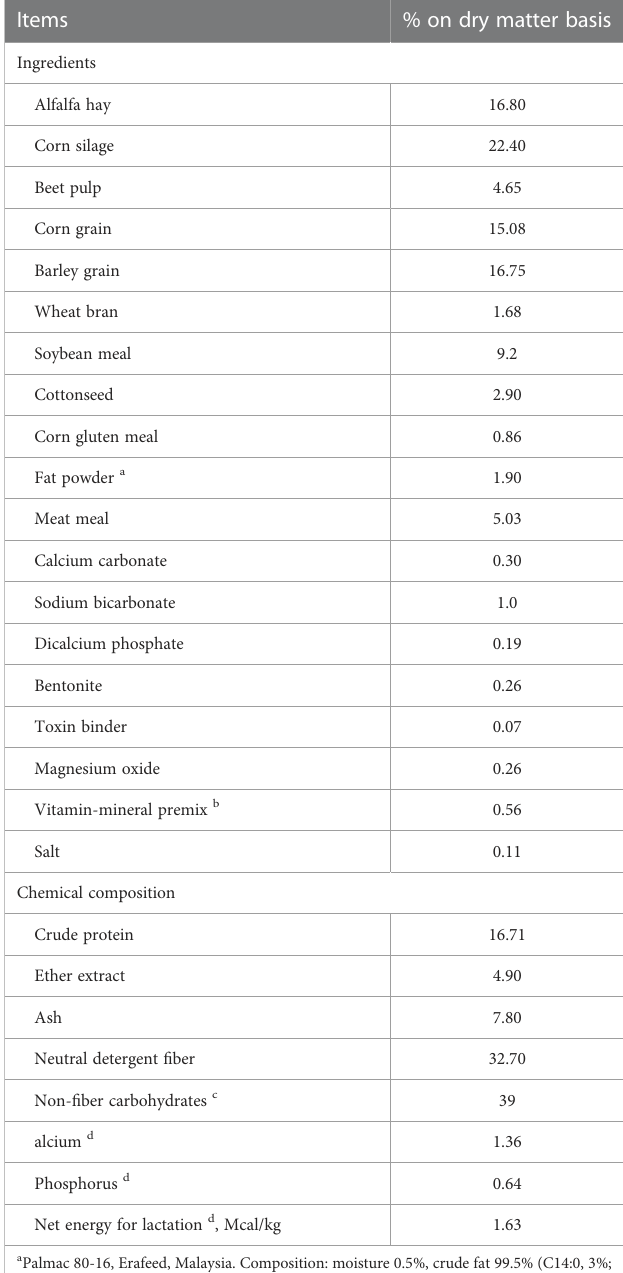
TABLE 2 Ingredients and chemical composition of the experimental diet. Items